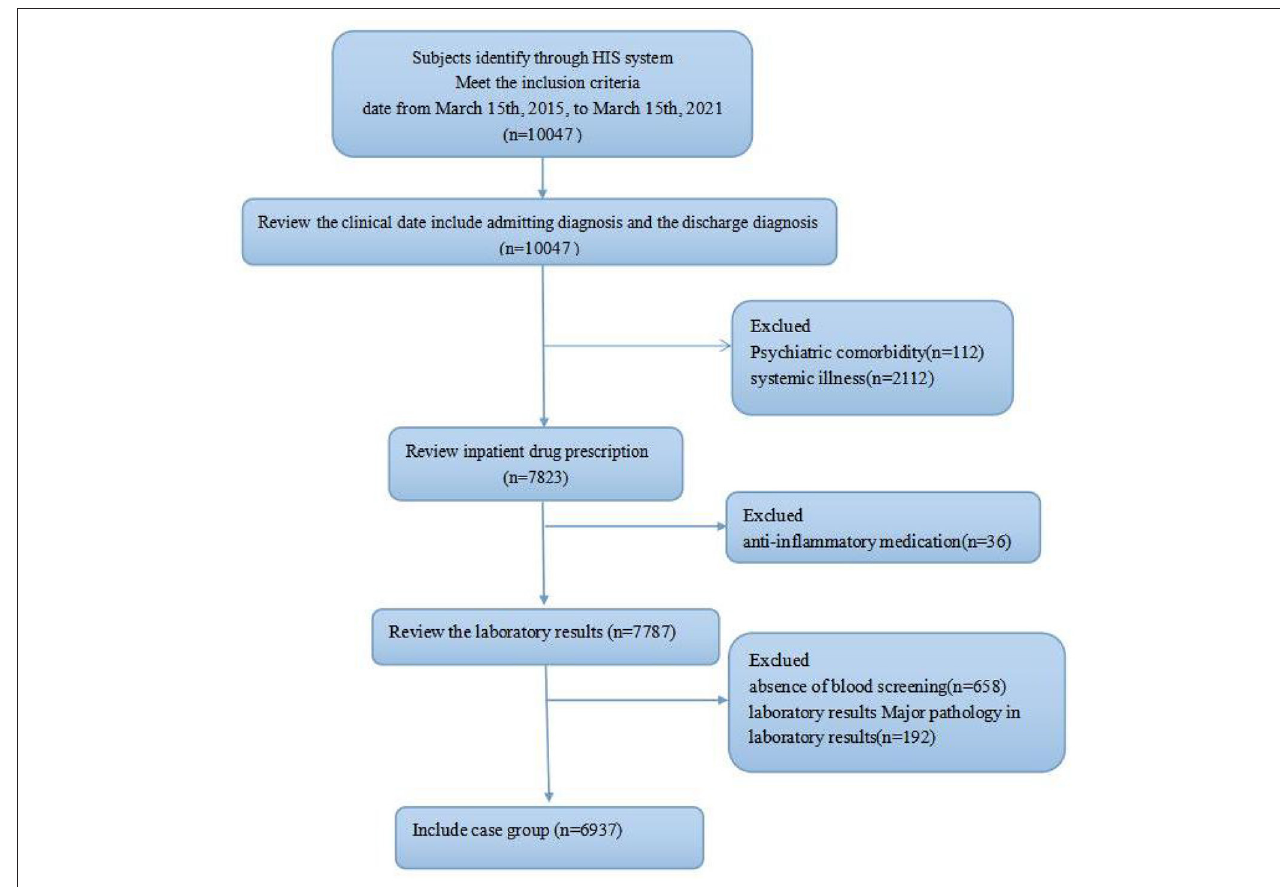
FIGURE 1 | Flow diagram of the patient selection process, showing the study inclusion and exclusion